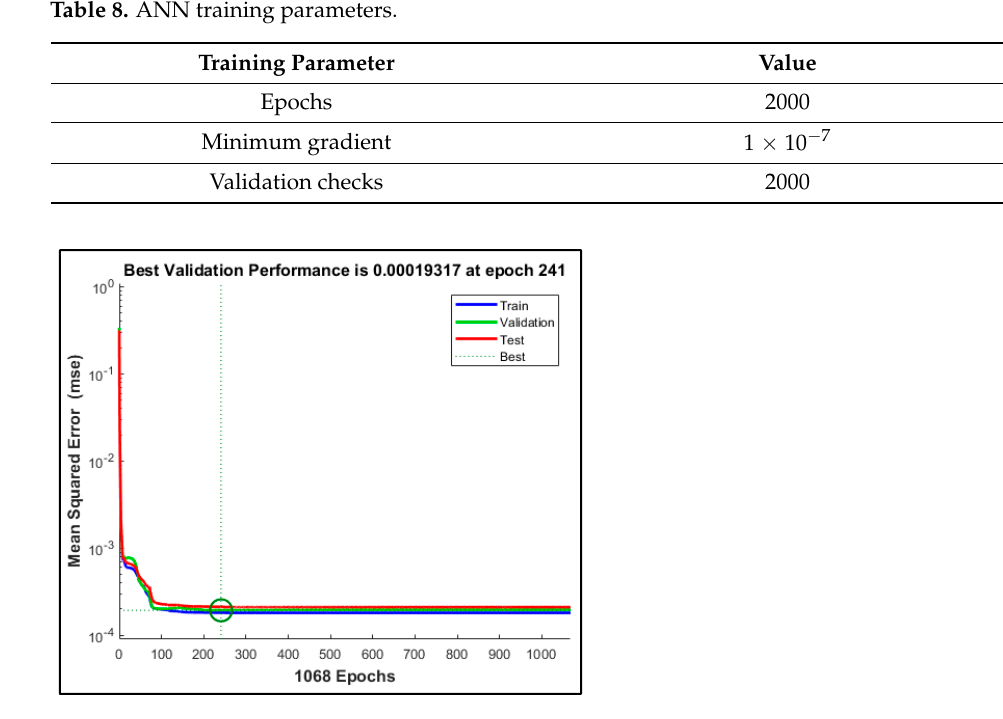
Figure 4. Validation performance of the ANN.